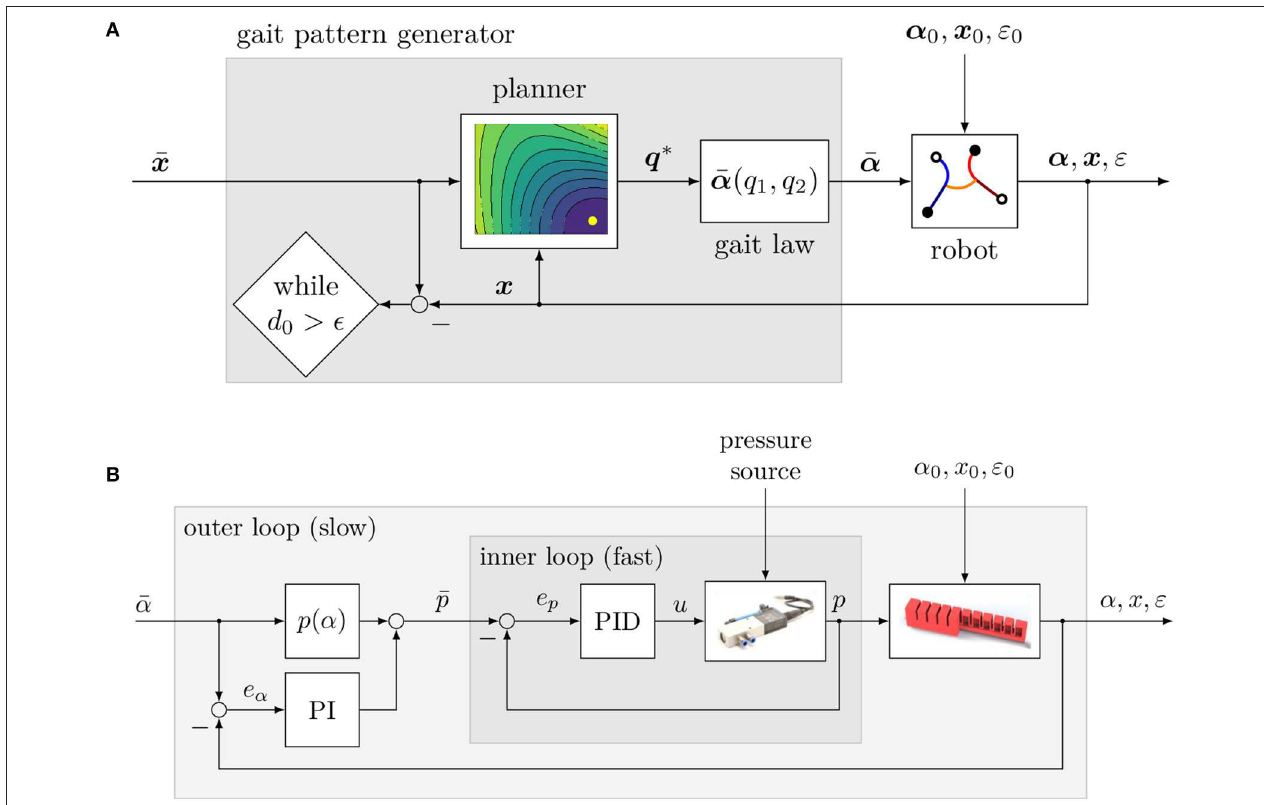
FIGURE 11 | Control architecture of the Gait Pattern Generator. (A) For a given target position ¯ x and the position of the robot x , the optimal step length q 1 and steering factor q 2 are calculated and then mapped into reference bending angles ¯ α ( · ) by the gait law, which are then fed into the robotic system. In (B) , the block diagram of a single actuator is shown. The reference bending angle ¯ α is mapped by a calibration function p ( α ) into a reference pressure ¯ p (feed forward term), which in turn is corrected by a saturated PI controller (feedback term). The reference pressure is then fed into the inner loop, where a PID controller generates the control input u for a proportional valve, which causes the pressure p to be applied to the actuator.